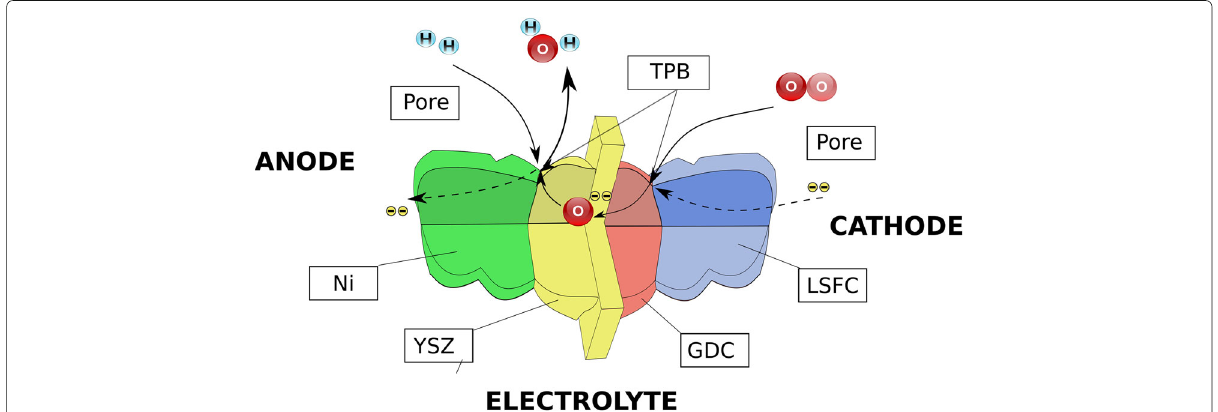
Fig. 1 A schematic view of the transport phenomena across a typical solid oxide fuel cell with a highlighted role of the microstructure